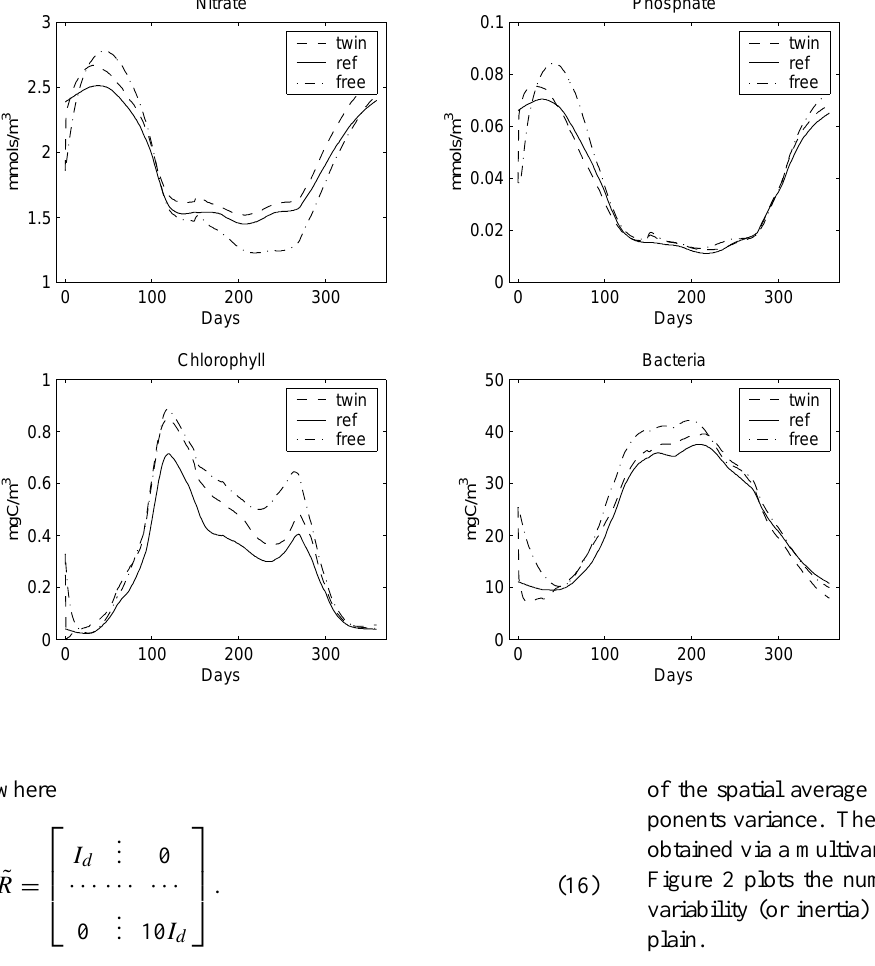
Fig. 3. Reference, model free run and filter estimation fields of nitrate, phos- phate, chl-a concentrations and bacteria